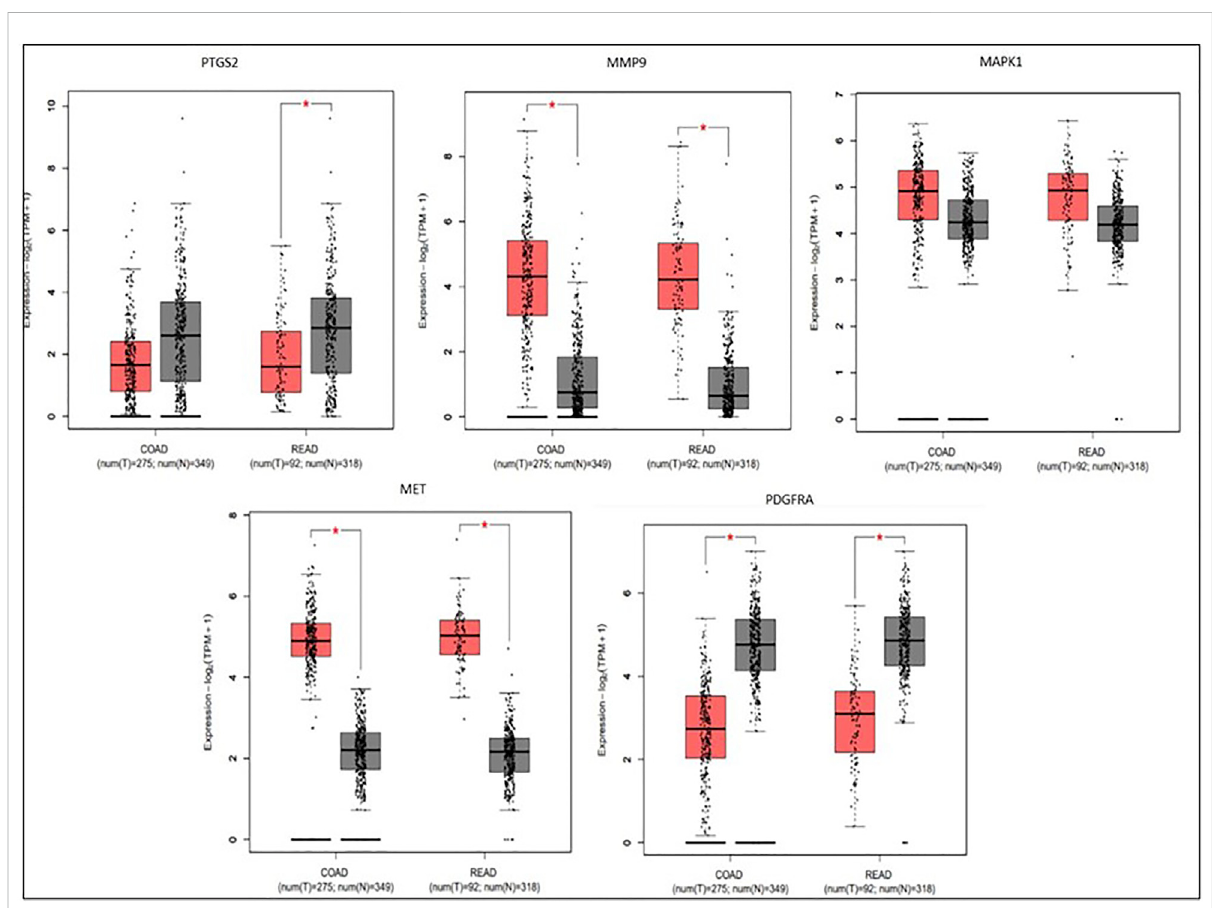
FIGURE 7 Survival plots for three genes (MET, PTGS2, and MAPK1) which was found to be involved in the overall survival of CRC patients among 19 hub genes.